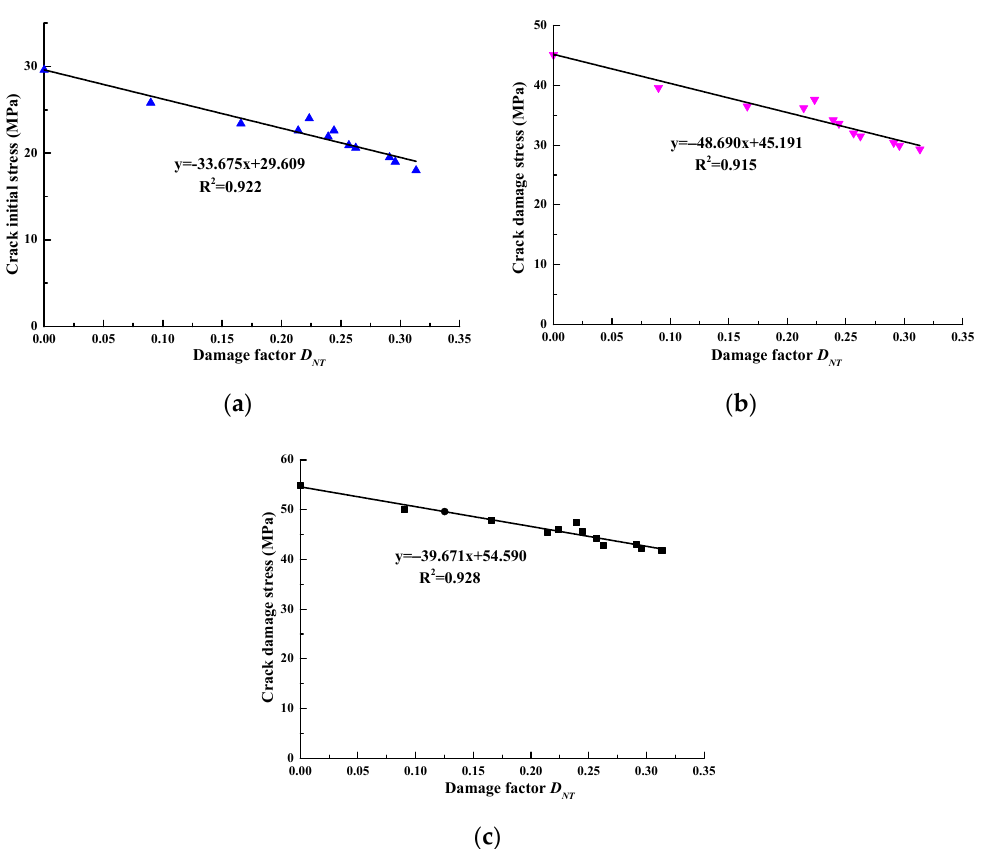
Figure 10. The relationship between the characteristic stress of the sandstone samples and D NT : ( a ) initial crack stress σ ci ; ( b ) crack closure stress σ cd ; ( c ) peak strength σ p .